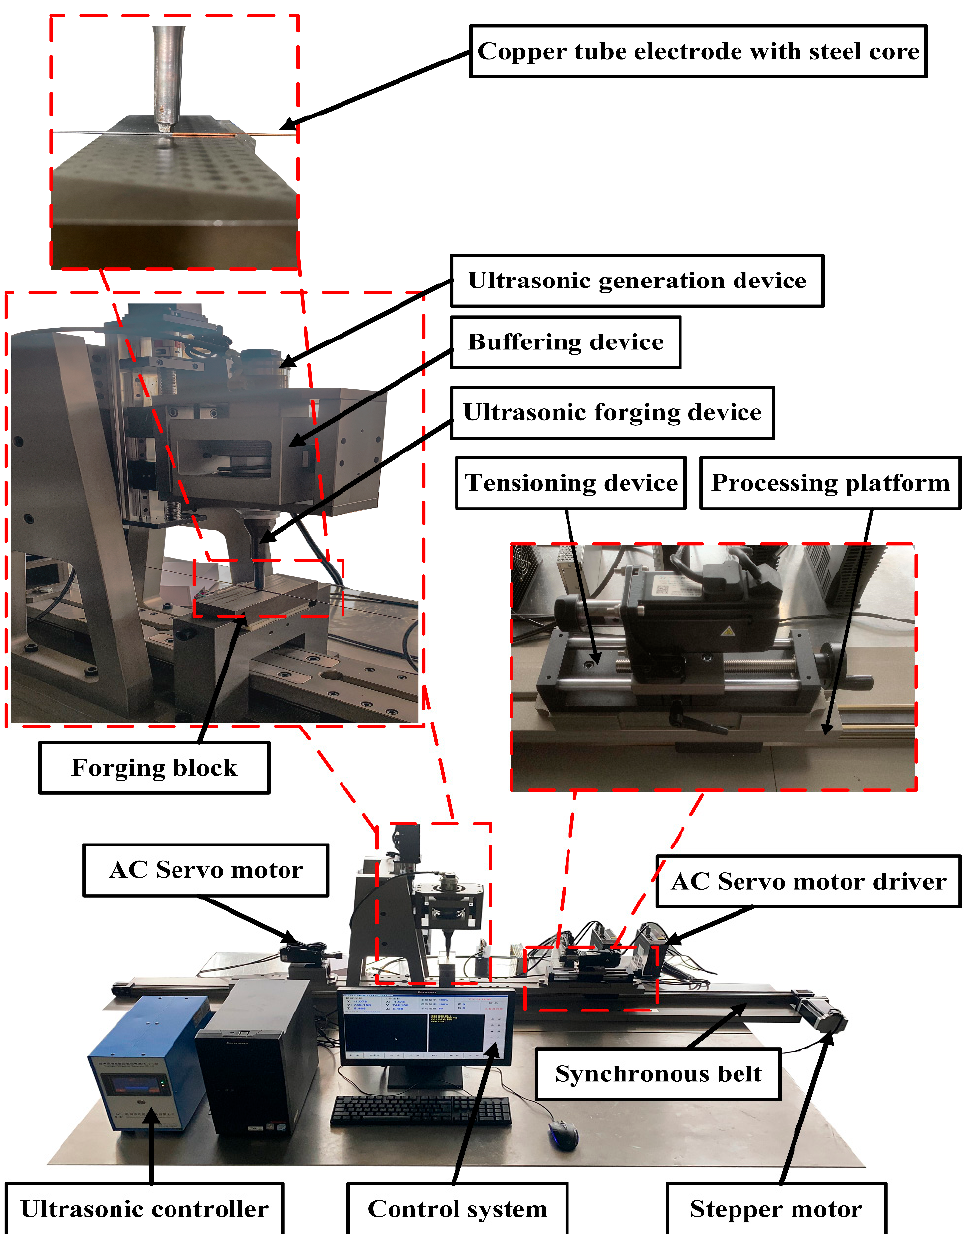
Figure 1. Ultrasonic high-frequency percussion fabrication of ultra-fine and ultra-long copper tube electrode experimental processing equipment.